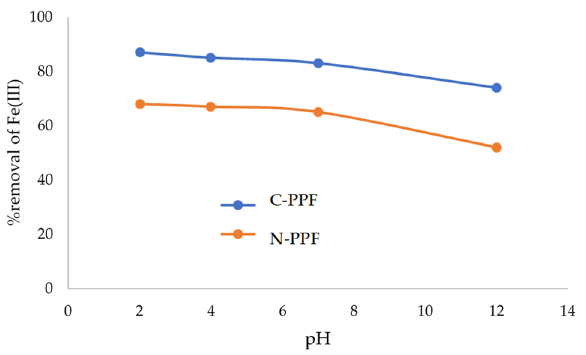
Figure 5. Variation in percentages of Fe(III) removal with pH values (at concentration of Fe(III) is 1 mg/L, 30 °C, 300 min and 2 g of adsorbent).